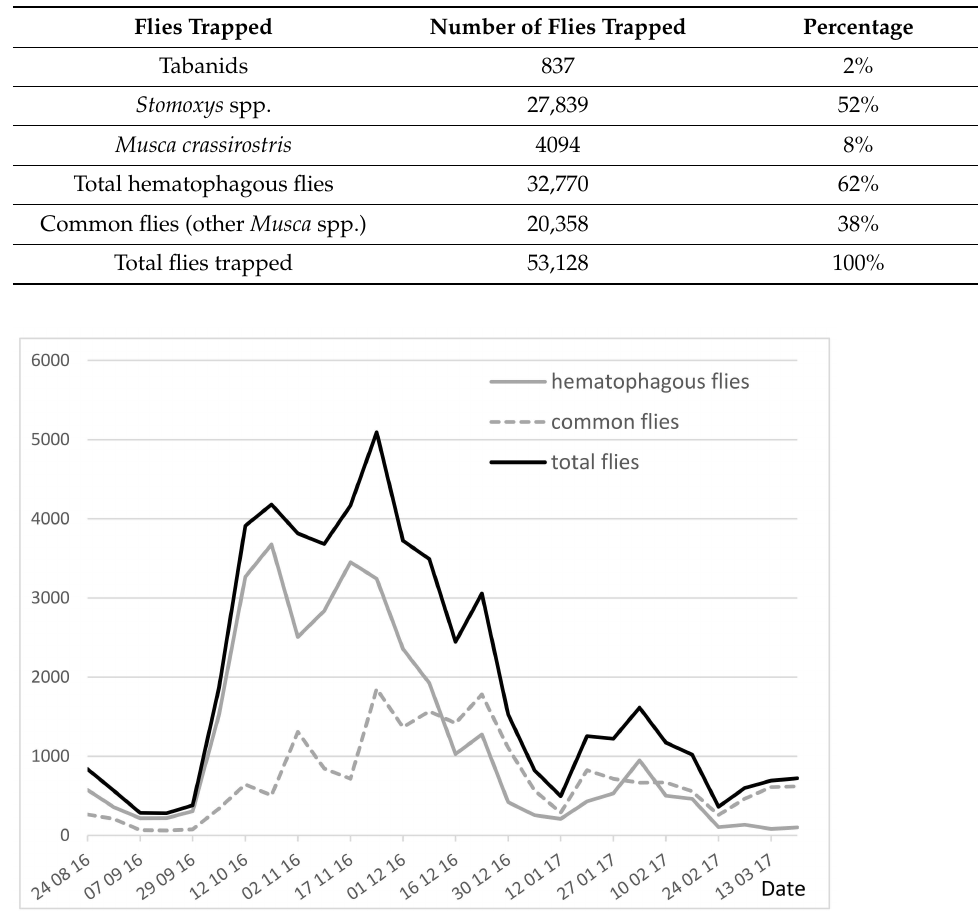
Table 2. Diurnal dipteran flies trapped during the study 24 August 2016–24 February 2017 (trapping sessions from 06:00 to 18:00) in the three traps (2 Vavoua and 1 Nzi).